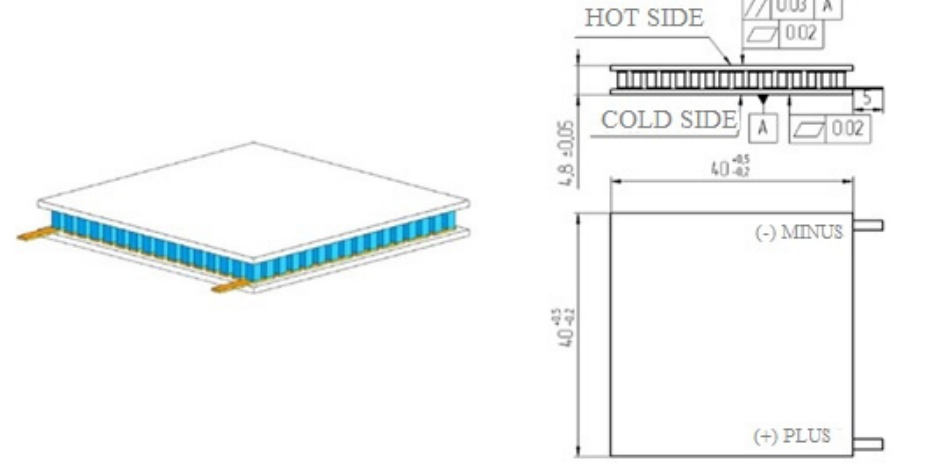
Figure 3. Thermoelectric module for the thermoelectric converter.